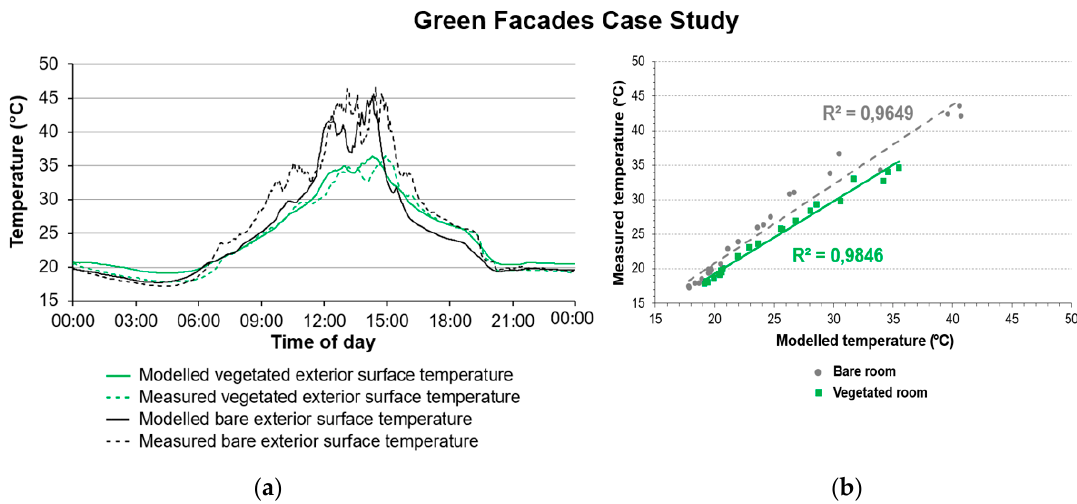
Figure 8. Comparison of the measured and modelled leaf temperature at the green facade on a sunny day 30 August 2017. ( a ) Presentation of temporal changes of the values and ( b ) Correlation analysis of the variables.